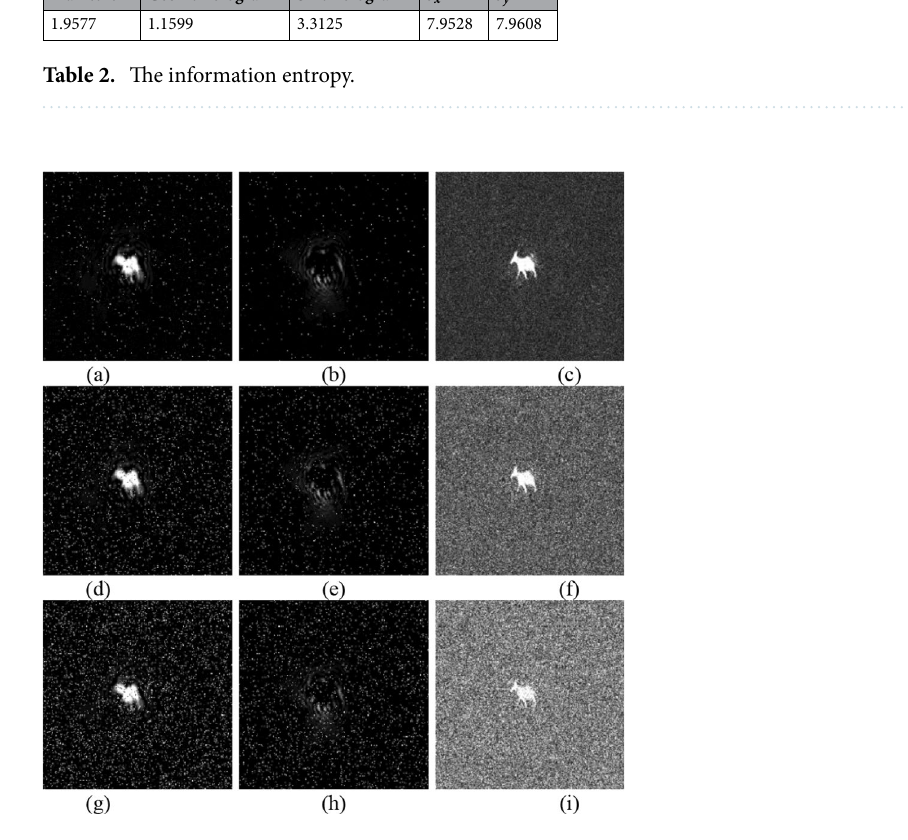
Figure 9. Decrypted images with salt and pepper noise ( a – c ) are reconstruction cosine and sine holograms and recovered image with 0.01 density, respectively; ( d – f ) are images with 0.05 density; ( g – i ) are images with 0.1